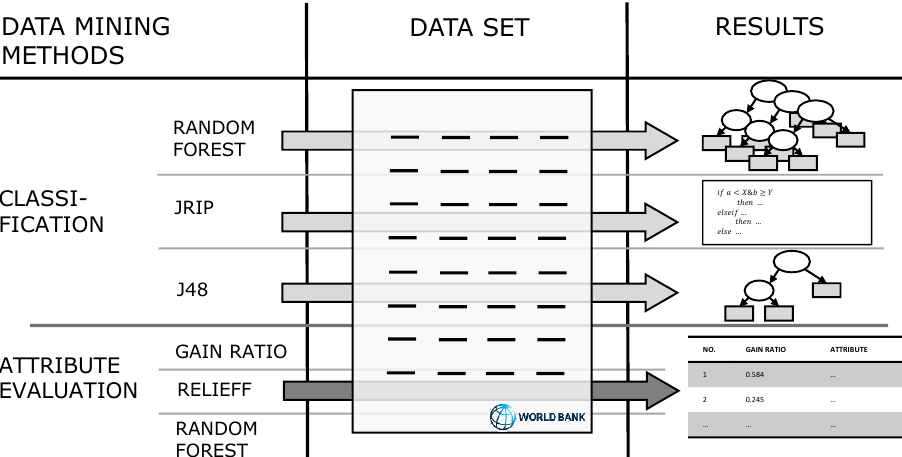
Figure 1. The framework of our research approach. The different methods will be introduced in the following Section